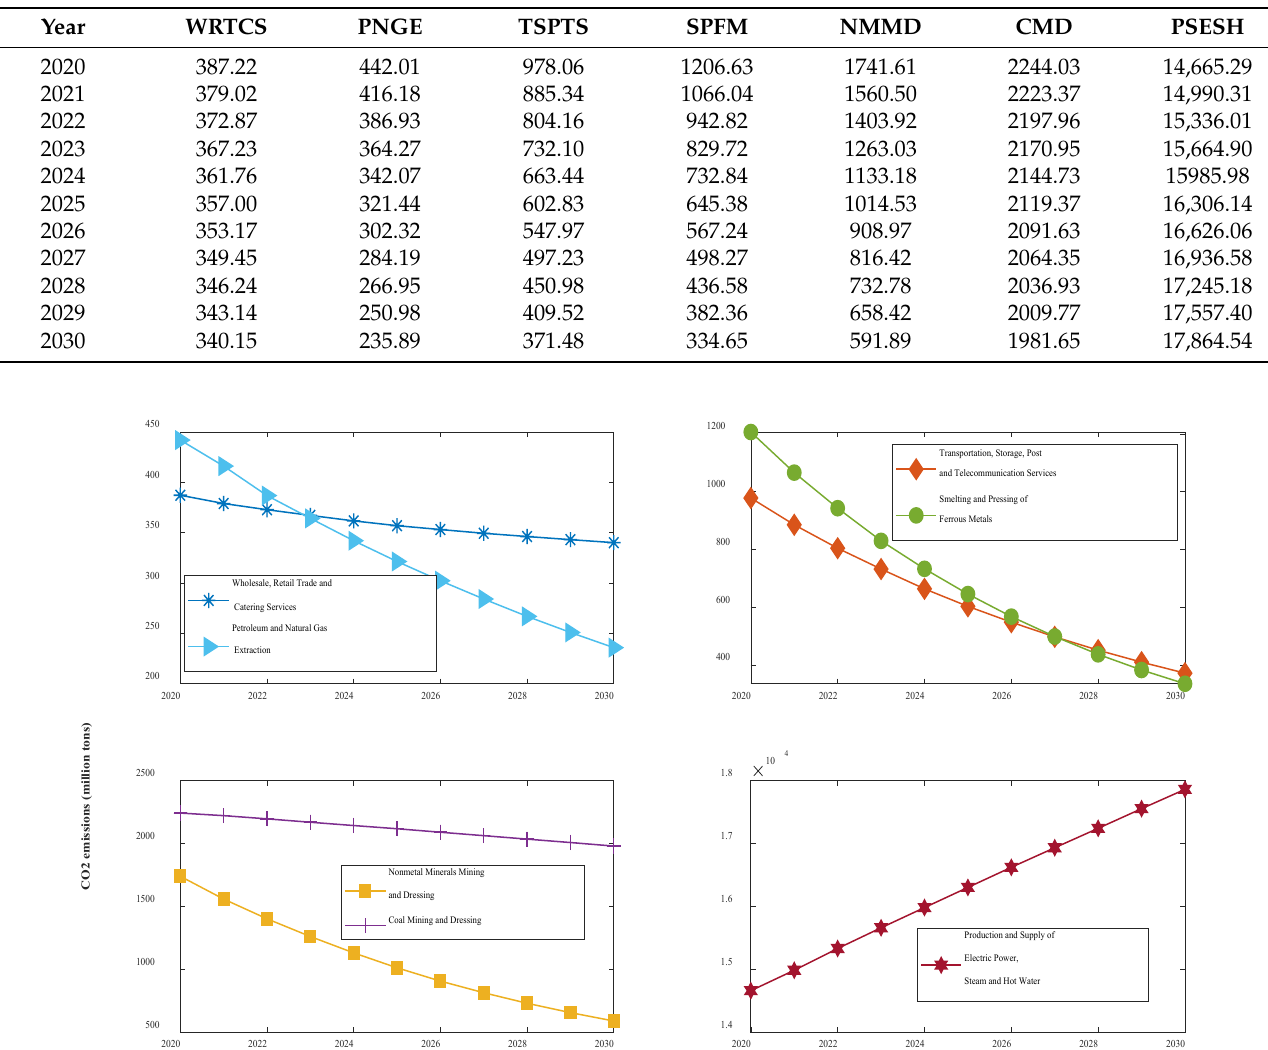
Table 9. Forecasted CO 2 emissions of 7 industries in Shaanxi (million tons).